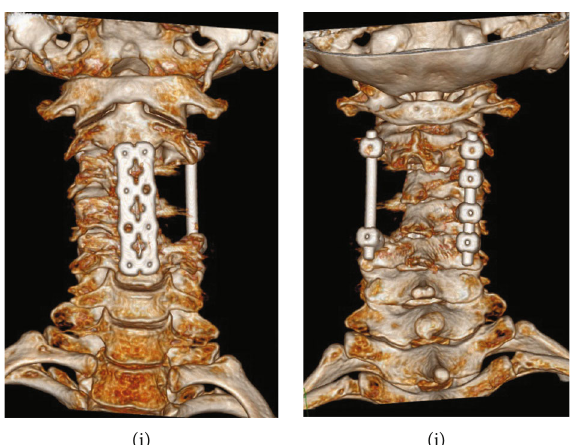
Figure 1: Case 1: aggressive osteoblastoma in C3/C4. (a – c) CT scan reconstructions of the cervical spine with a left-sided osteolysis in C3 and C4. (d, e) MRI shows the extent of the tumor and its close relation to the vertebral artery. (f) En bloc resected tumor. (g, h) Postoperative a.p. and lateral radiographs after resection of the tumor and combined posteroanterior stabilization. (i, j) CT scan 3-D reconstructions show the osseous defect after tumor